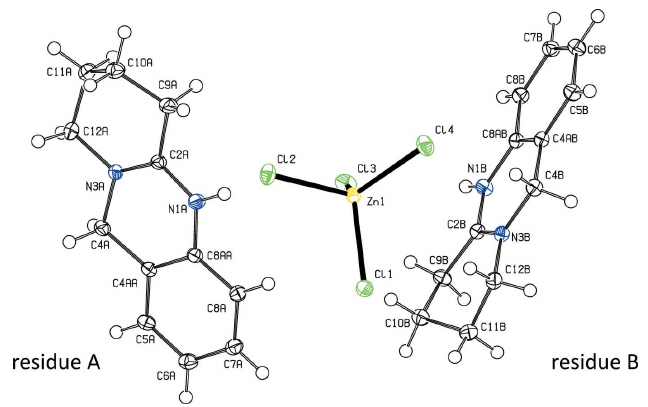
Figure 1 Asymmetric unit of the title compound with the atom-numbering scheme (Spek, 2020). Displacement ellipsoids for non-hydrogen atoms are drawn at the 50% probability level.